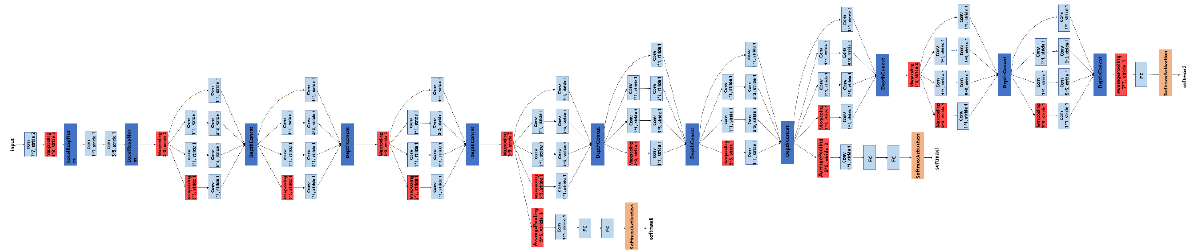
Figure 10. Structure of GoogleNet.